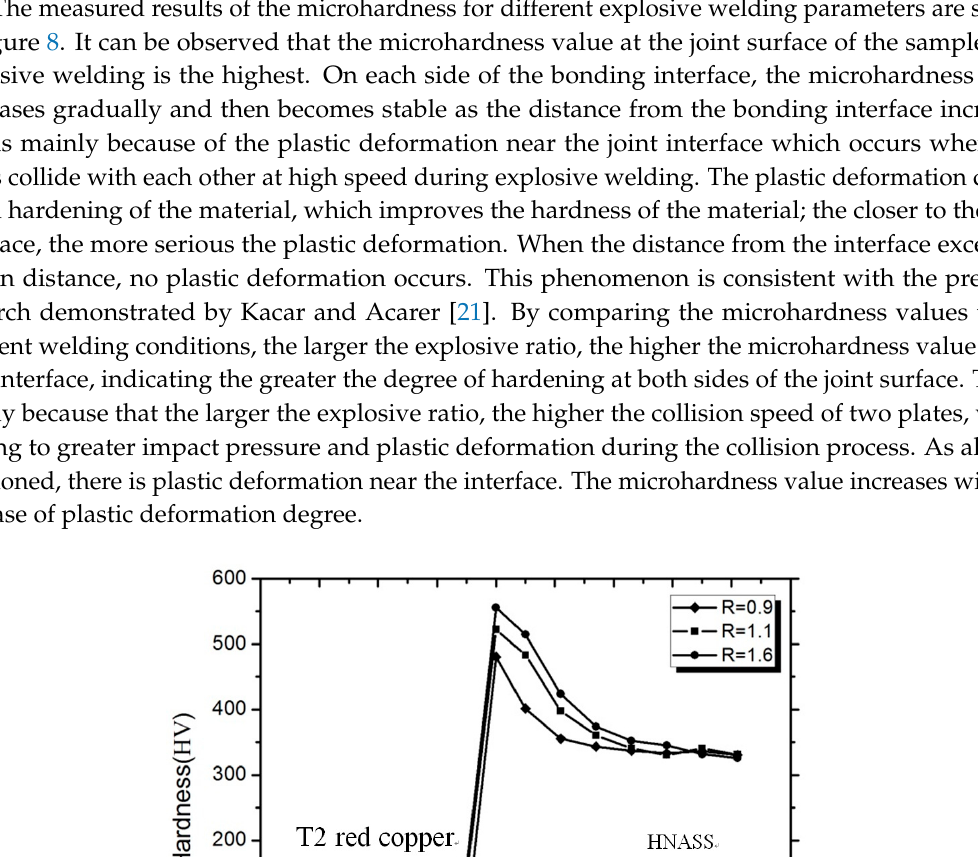
Table 4. Test results of tensile shear of T2 red copper/HNASS under different explosive welding parameters.